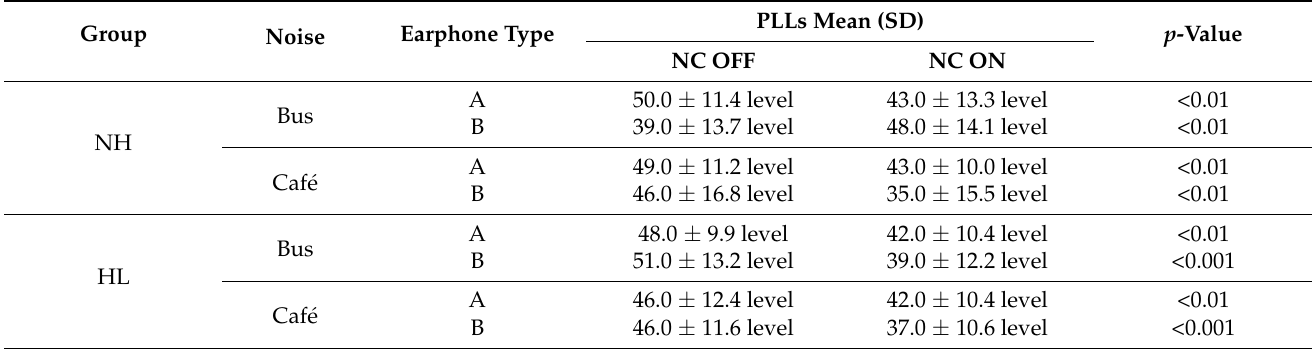
Table 3. PLLs when the NC function is turned on and off in both